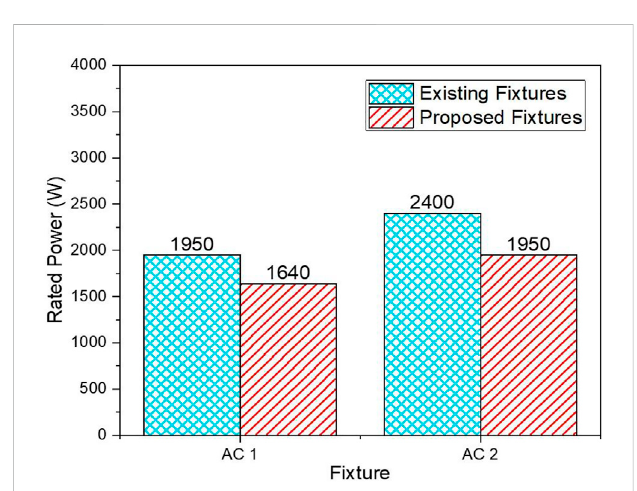
FIGURE 3 Comparison of energy consumption in the existing and proposed air conditioners.